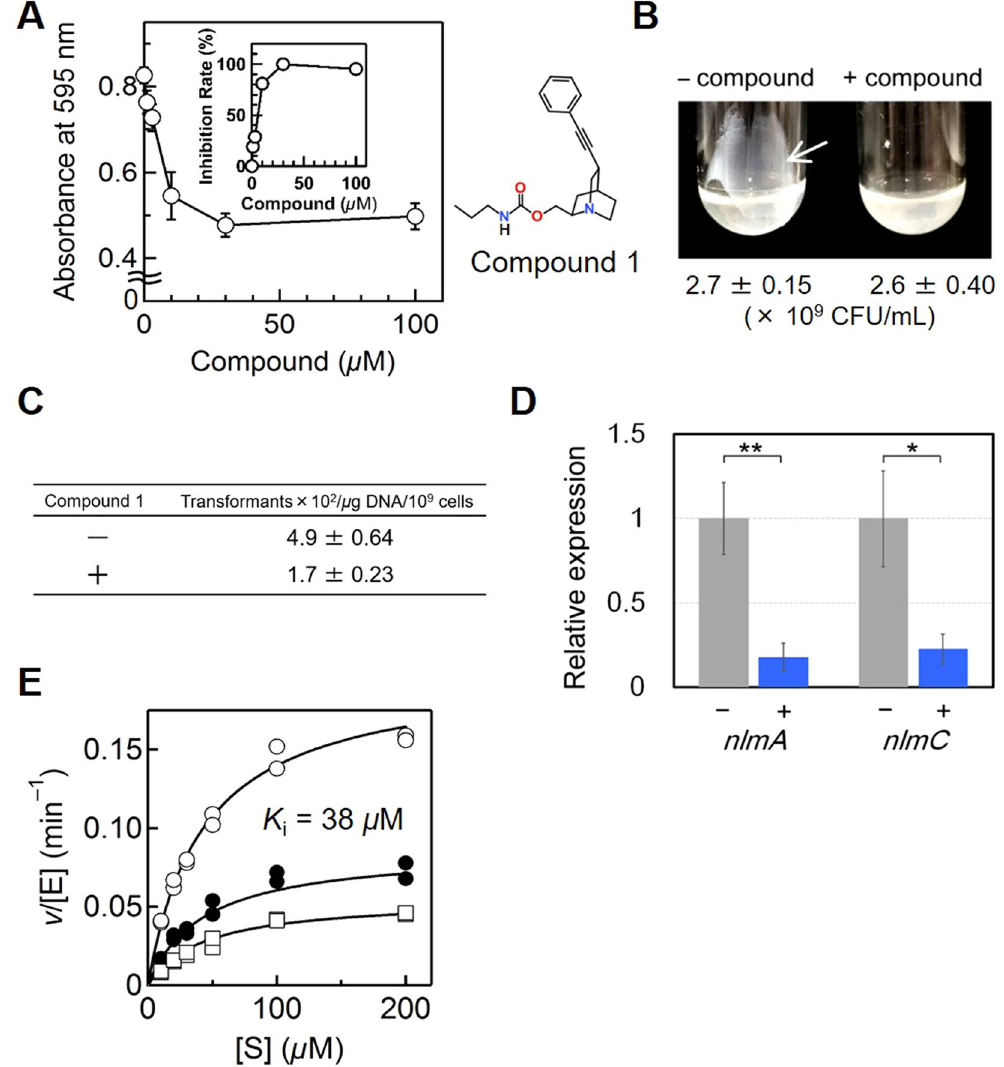
Figure 2. Examination of in vivo and in vitro Activities of Compound 1. ( A ) Biofilm mass of S. mutans (means ± SD, n = 3) in the presence of various concentrations of Compound 1 estimated by crystal violet staining. Inhibition rates were calculated with the maximum suppression of biofilm formation as 100% ( inset ). ( B ) Images of the biofilm of S. mutans in the absence or presence (25 μ M) of Compound 1 formed on the walls of polystyrene test tubes. The white arrow indicates the biofilm of S. mutans , which formed on the wall of a tilted tube after the overnight standing culture. Numbers of viable cells from the same experiment (means ± SD, n = 3) are indicated below (CFU, colony forming unit). ( C ) Transformation efficiency (means ± SD, n = 3) of S. mutans in the absence or presence (10 µ M) of Compound 1. ( D ) Relative mRNA expression levels (means ± SD, n = 3) of the nlmA and nlmC genes of S. mutans in the absence or presence (25 μ M) of Compound 1 were examined by quantitative RT-PCR ( * p = 0.017, ** p = 0.0045). ( E ) v /[E] versus substrate concentrations plots of the MuPEP1 peptidase assay for tCComC-AFC in the absence ( ○ ) or presence ( ● , 50 μ M and □ , 100 μ M) of Compound 1 (n = 2). Theoretical curves were fitted by the non-competitive inhibition model with the parameters of k cat = 0.20 min − 1 , K m = 43 μ M, and K i = 38 μ